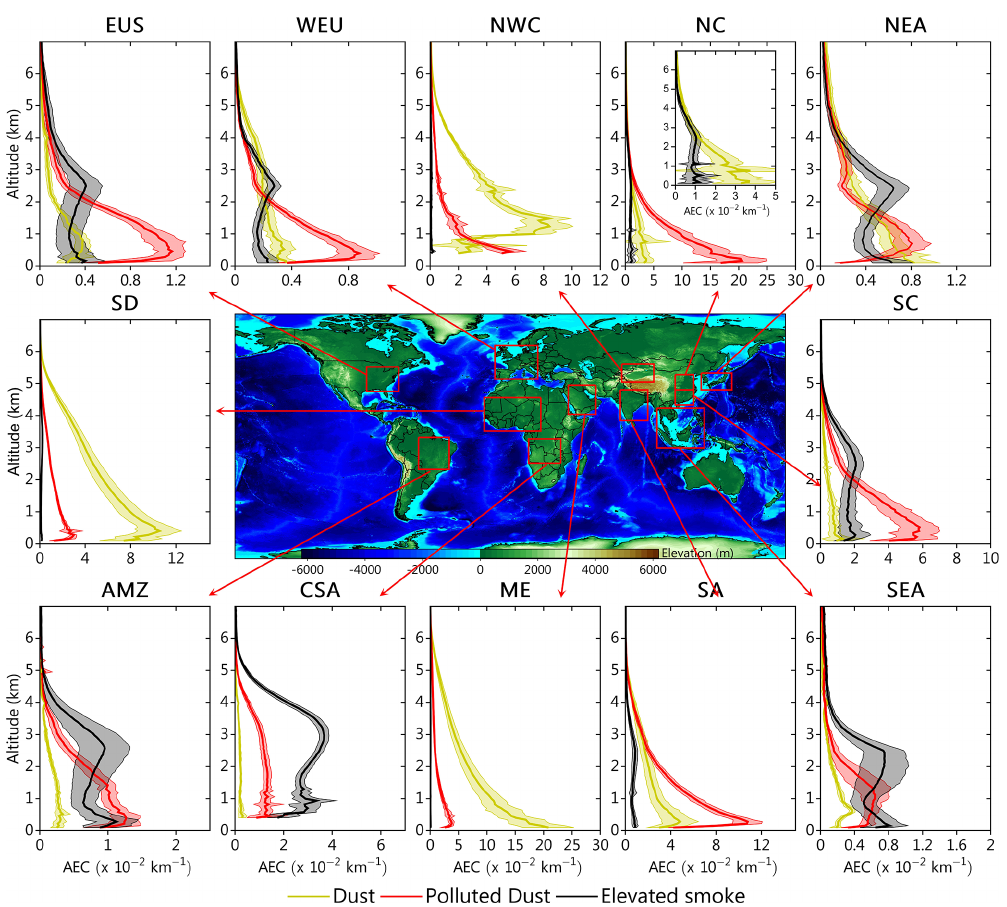
Figure 6. Regional-averaged vertical profiles of multi-year averaged AEC for type-dependent aerosols (dust, PD and smoke) over the 12 ROIs. The shading in each subpanel represents the multi-year average standard deviation.